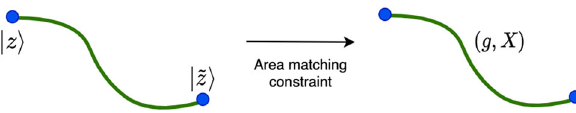
Fig. 6 In spinorial LQG we label each end of an edge with spinors ( | z (cid:5) , |˜ z (cid:5) ) ∈ C 2 × C 2 . Applying the area matching constraint (cid:16) z (cid:16) 2 − (cid:16)˜ z (cid:16) 2 = 0, we obtain the phase space variables ( g , X ) , with g ∈ SU ( 2 ) and X ∈ su ( 2 )